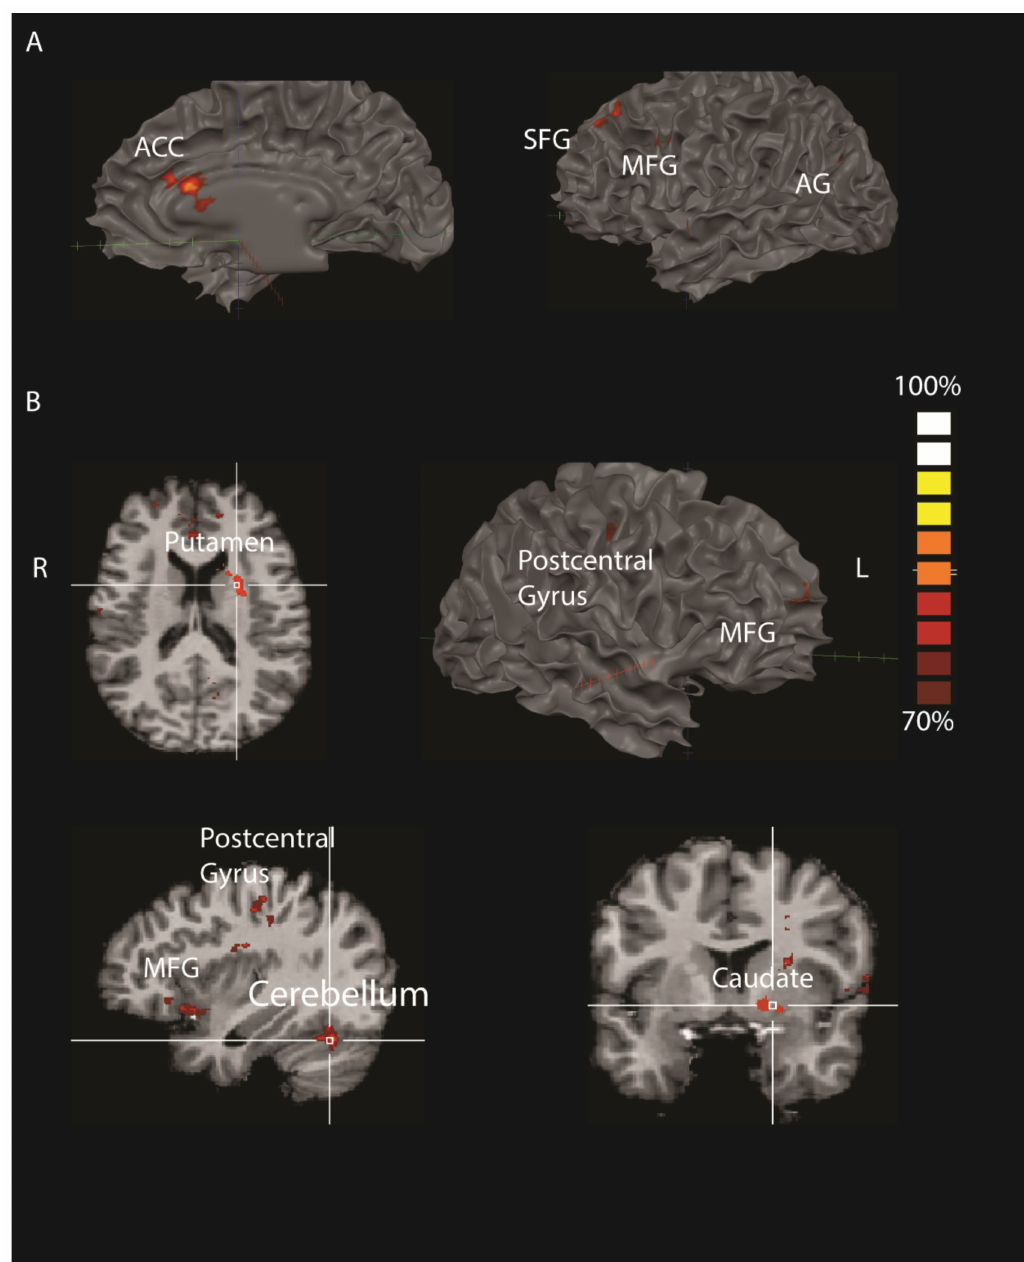
Figure 6. Multi-voxel pattern analysis of brain activations related to CET numerical quantity com- pared to time ( A ) and numerical quantity compared to weight ( B ). ( A ). Results of this analysis revealed differences in the quantity versus time categories in various frontal regions: left superior frontal gyrus (SFG), middle frontal gyrus (MFG), and right anterior cingulate cortex (ACC). Moreover, this analysis revealed differences in the left angular gyrus (AG). ( B ). Results of this analysis revealed differences in the quantity versus weight categories in the right and left middle frontal gyrus (MFG), the right postcentral gyrus, the left putamen, the left caudate, and in the right